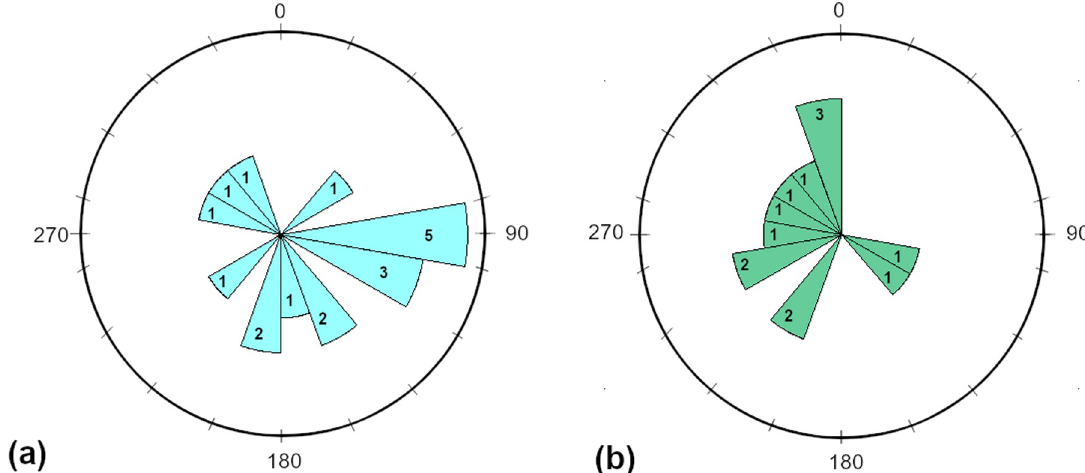
Fig 23. Rose diagrams of track orientations for at BP1 and BP3. Rose diagrams show the orientation of the central axis of all footprints for which this parameter could be measured from (a) BP1 and (b) BP3. These diagrams illustrate that there was no preferred direction of movement among the dinosaurs at either tracksite. The total number of tracks tabulated for BP1 was 18 and for BP3 was 13.